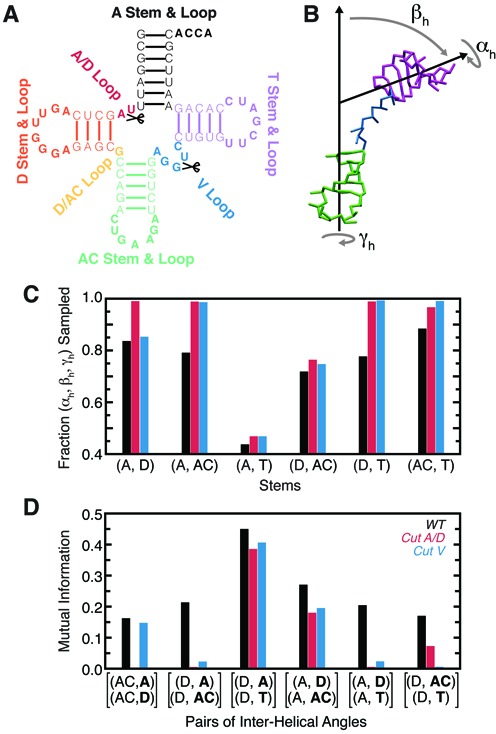
Secondary structure limits the set of global conformations accessible to WT tRNA. (A) Secondary structure and labeling scheme of tRNAPhe. Loop residues are bolded and cut locations marked. (B) The Euler angle convention used to describe the relative 3D orientation of RNA helices. Shown is a representative TOPRNA snapshot of the AC- and T-stems, colored as in (A), with the A- and D-stems and connecting loops not shown for clarity. (C) Fraction of possible (αh, βh, γh) angles sampled between pairs of tRNA helices by the WT (black), cut A/D-loop (red) and cut V-loop (blue) simulations. (D) The mutual information (MI) between pairs of interhelical Euler angles measured with respect to a common reference helix. The two helices whose orientations are being correlated are bolded.